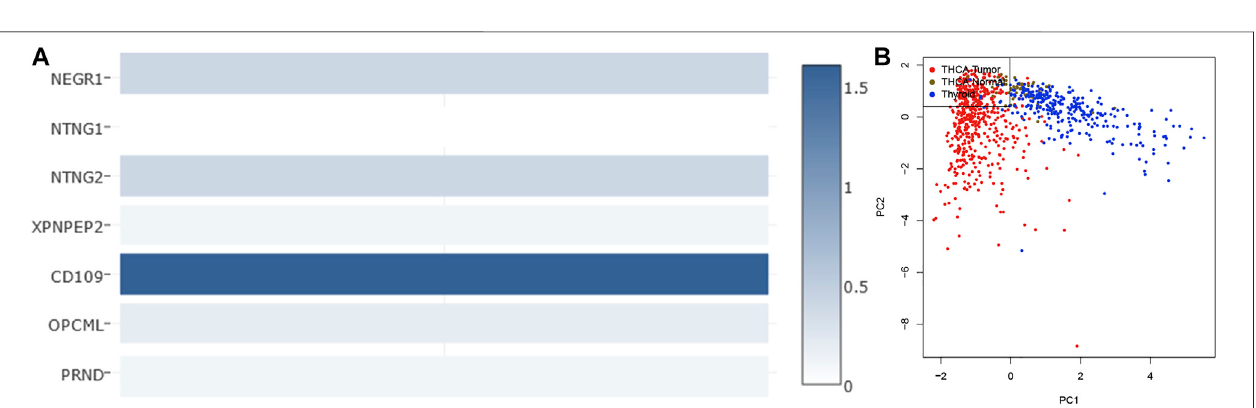
FIGURE 7 | Multiple-gene comparison analysis (A) and principal component analysis (B) of the seven-gene biomarker in THCA.